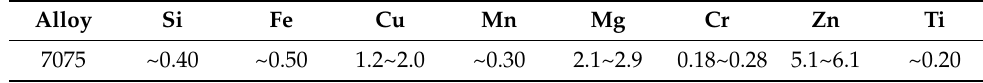
Table 1. Chemical composition of AA7075 (mass %).